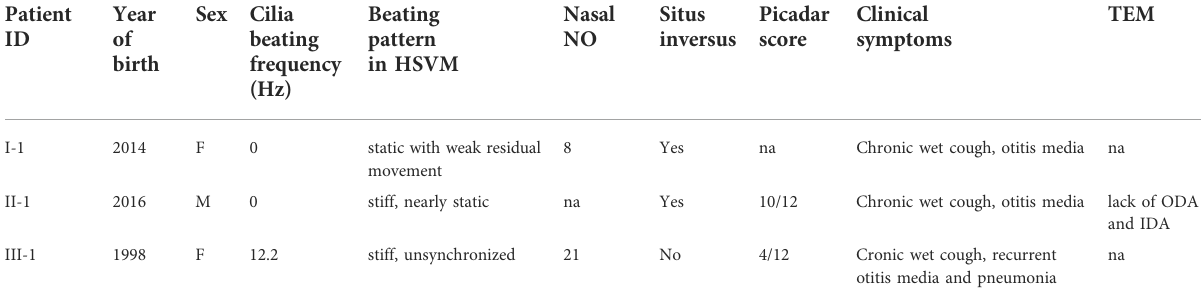
TABLE 1 PCD patient characteristics for patients with LoF mutations in CFAP300